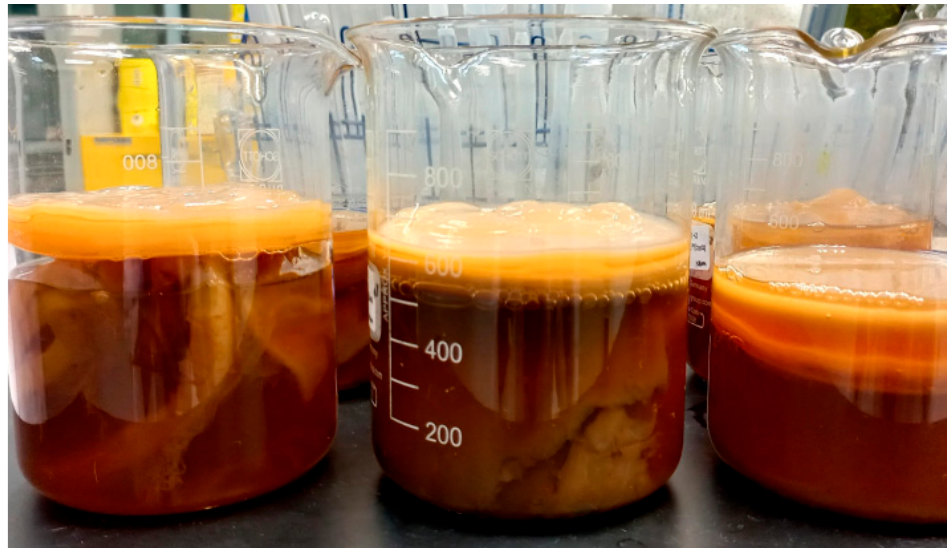
Figure 2. Laboratory-fermented black tea (kombucha).